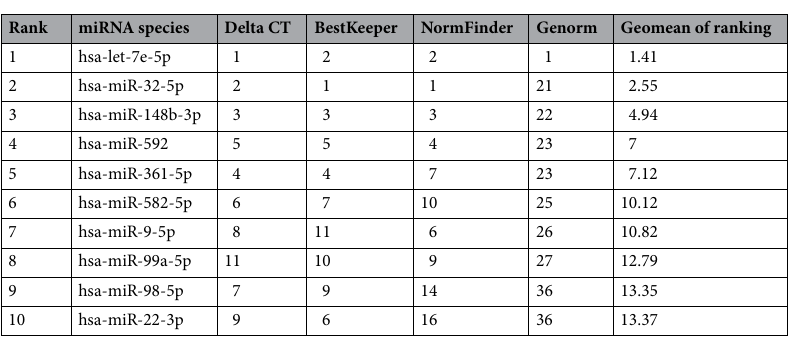
Table 1. RefFinder ranking of miRNA